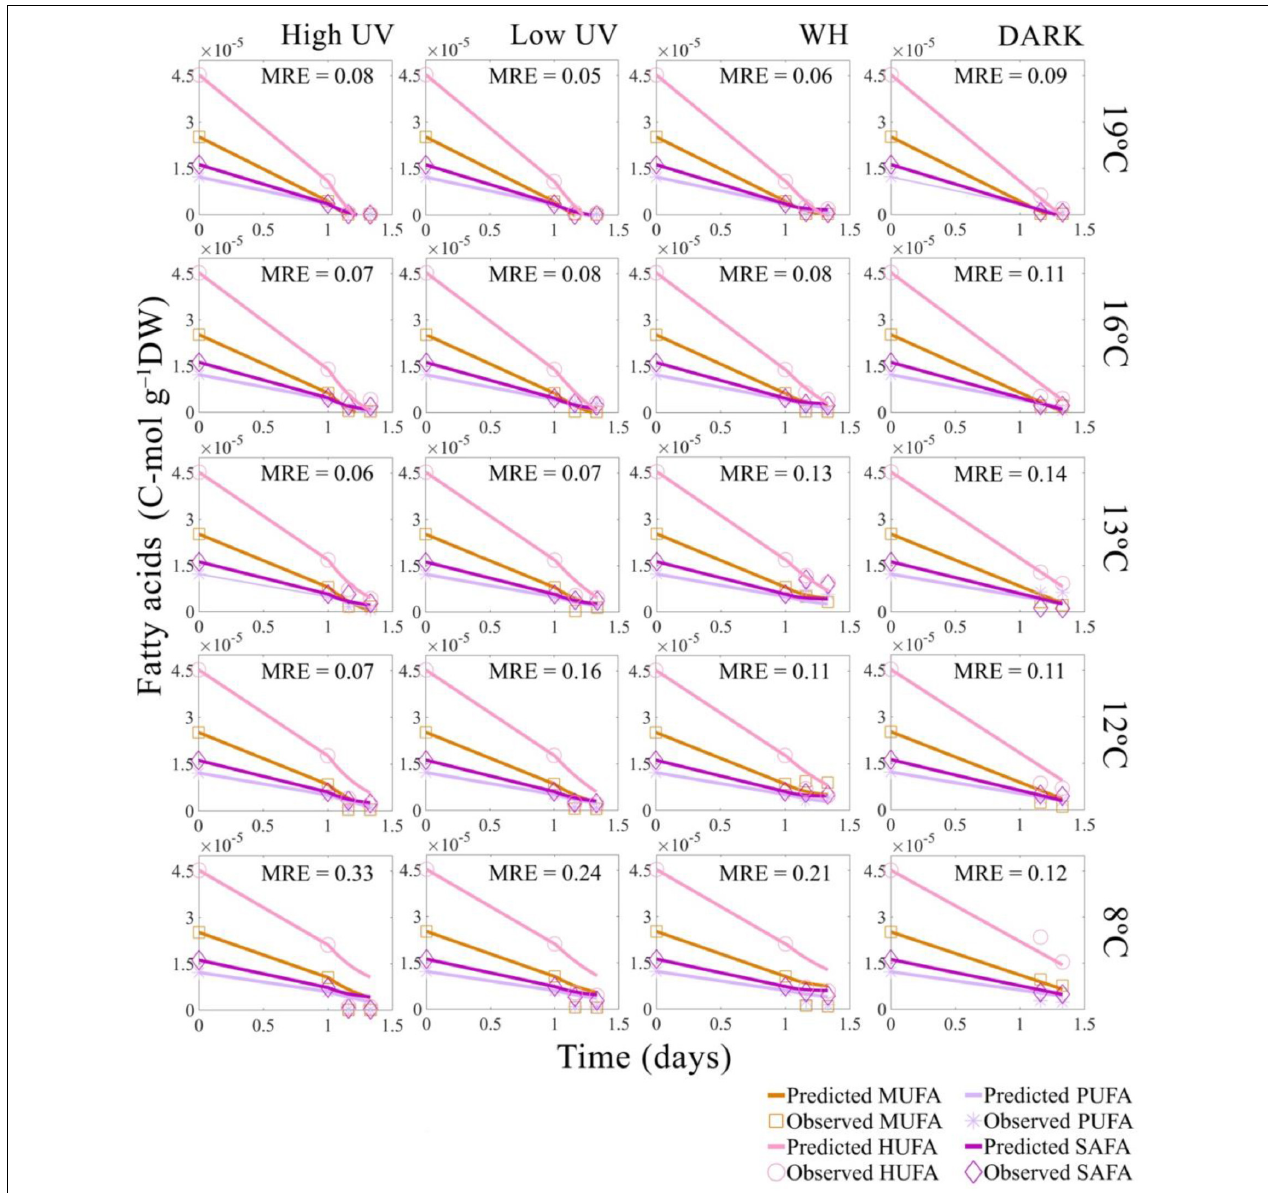
FIGURE 3 | Predicted and observed decrease in Nyctiphanes australis fatty acid concentration in time for all temperatures and light treatments: high UV, low UV, PAR, and DARK with the mean across fatty acids types relative error of the DEB model predictions (MRE). Values used for the DEB model are the total sum of fatty acids converted into C-moles. For model predictions of UV and PAR treatments the value of fatty acids at 1 day (24 h) of starvation was interpolated from the negative control data, which is krill not experimentally exposed to light.